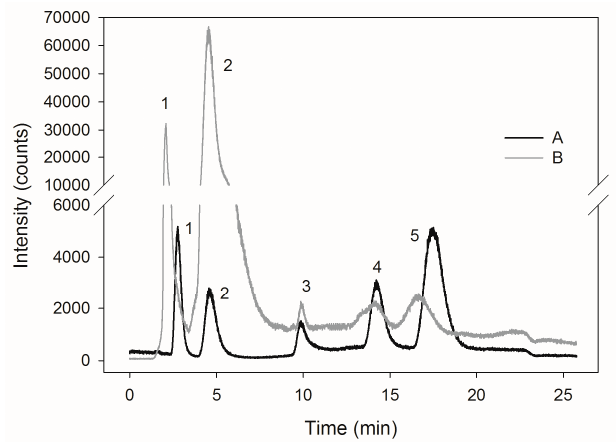
Figure 2. Chromatograms of a mixture of selenium compounds standards (A), reference material SELM-1 (B). The retention times were as follows: (1) seleno-methyl-selenocysteine, SeMetSeCys = 2.8